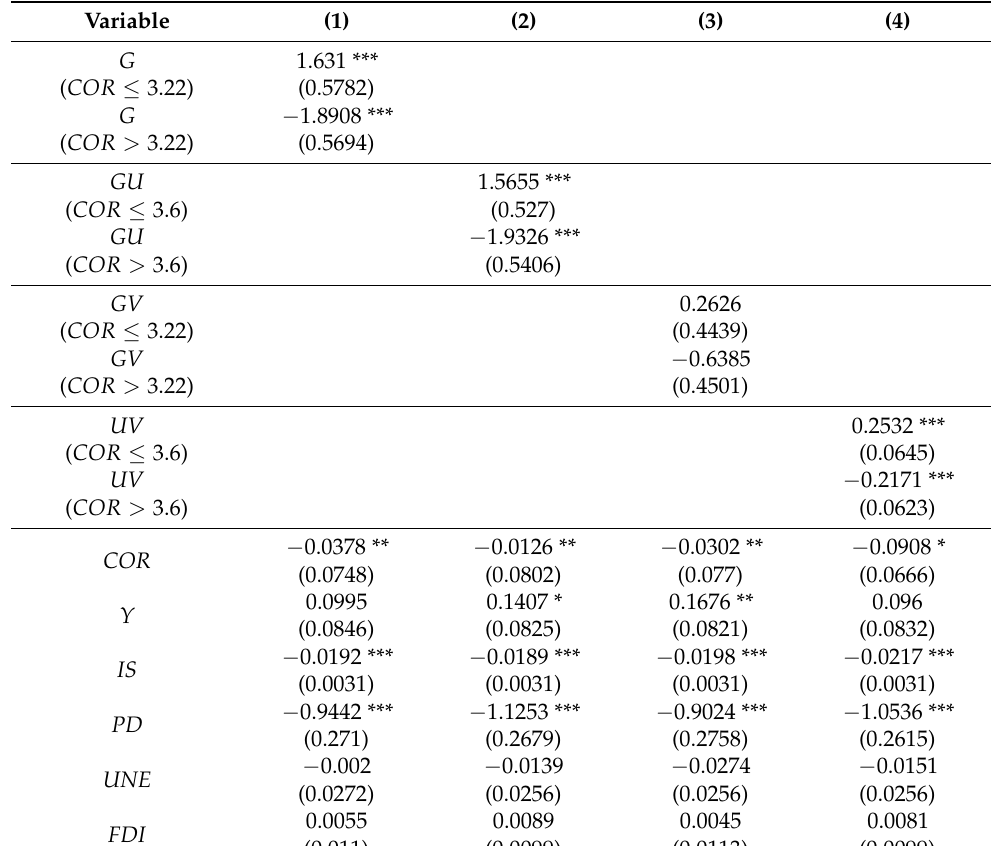
Table 3. Baseline regression